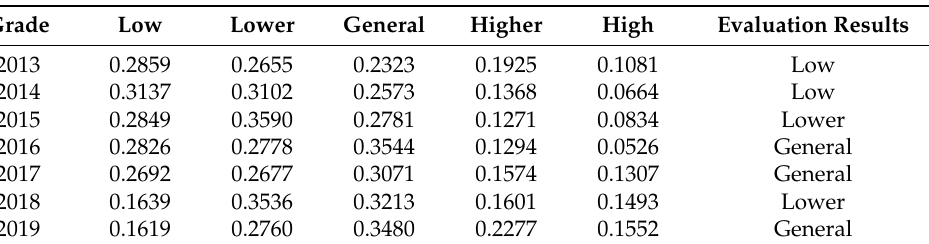
Table 12. Evaluation Results of Logistics Decarbonization Development in Hebei Province from 2013 to 2019.